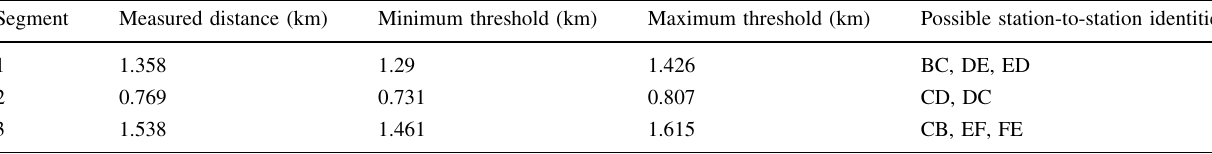
Table 3 Viable segments for sequence-based classification algorithm example